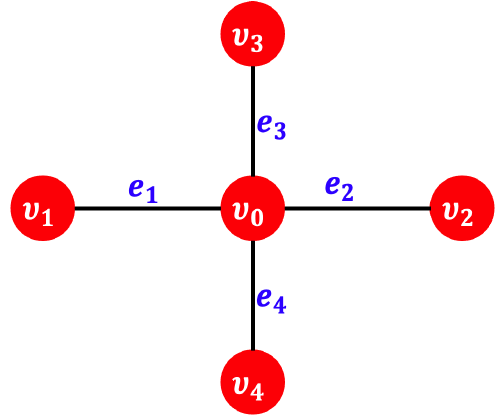
Figure 3. A sketch of a graph with three edges and four vertices.